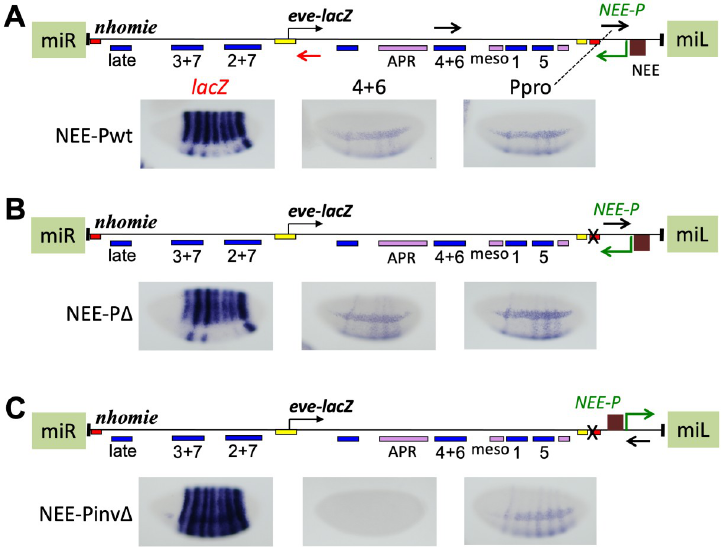
Fig 5. Driving a flanking P-element promoter with a heterologous enhancer induces non-coding transcription, and if it causes read-through, repression of the eve promoter. eve-lacZ and non-coding RNA expression in stage 5 embryos from eve pseudo-loci flanked by a 5’ P-element promoter and a neuroectodermal enhancer ( NEE , brown square), inserted at the same MiMIC site as in Fig 4, and in the same orientation. The 3 loci (map above each one) differ only in the presence ( A , NEE-Pwt) or absence ( B , NEE-P Δ and C , NEE-Pinv Δ ) of homie , and in the orientation of the NEE , P-pro cassette ( NEE-P , pointing to the left in A and B, and to the right in C). Positions and orientations of the RNA probes are shown as black and red arrows in the map in A (and in B and C for the probe closest to the P- promoter). Embryos were stained with the probes listed in A, using either black lettering corresponding to black arrows in the map (detecting transcription from right to left), or red lettering corresponding to the red arrow (detecting transcription from left to